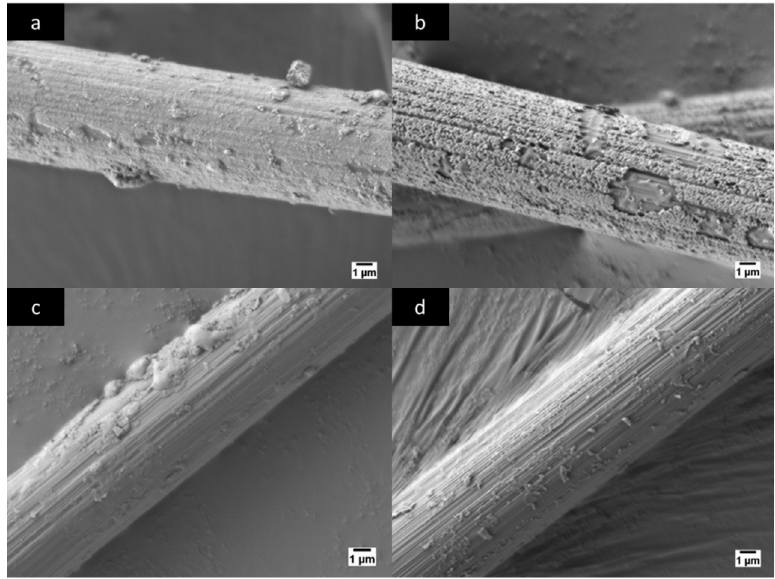
Figure 4. Images from scanning electron microscope (Jeol JSM-7600F) taken with 5000x magnification: ( a ) Untreated nickel-coated carbon fiber; ( b ) nickel-coated carbon fiber after treatment of 3% H 2 O 2 + 37% HCl; ( c ) nickel-coated carbon fiber after treatment of 6 % H 2 O 2 + 37% HCl; ( d ) nickel-coated carbon fiber after treatment of 10% H 2 O 2 + 37%